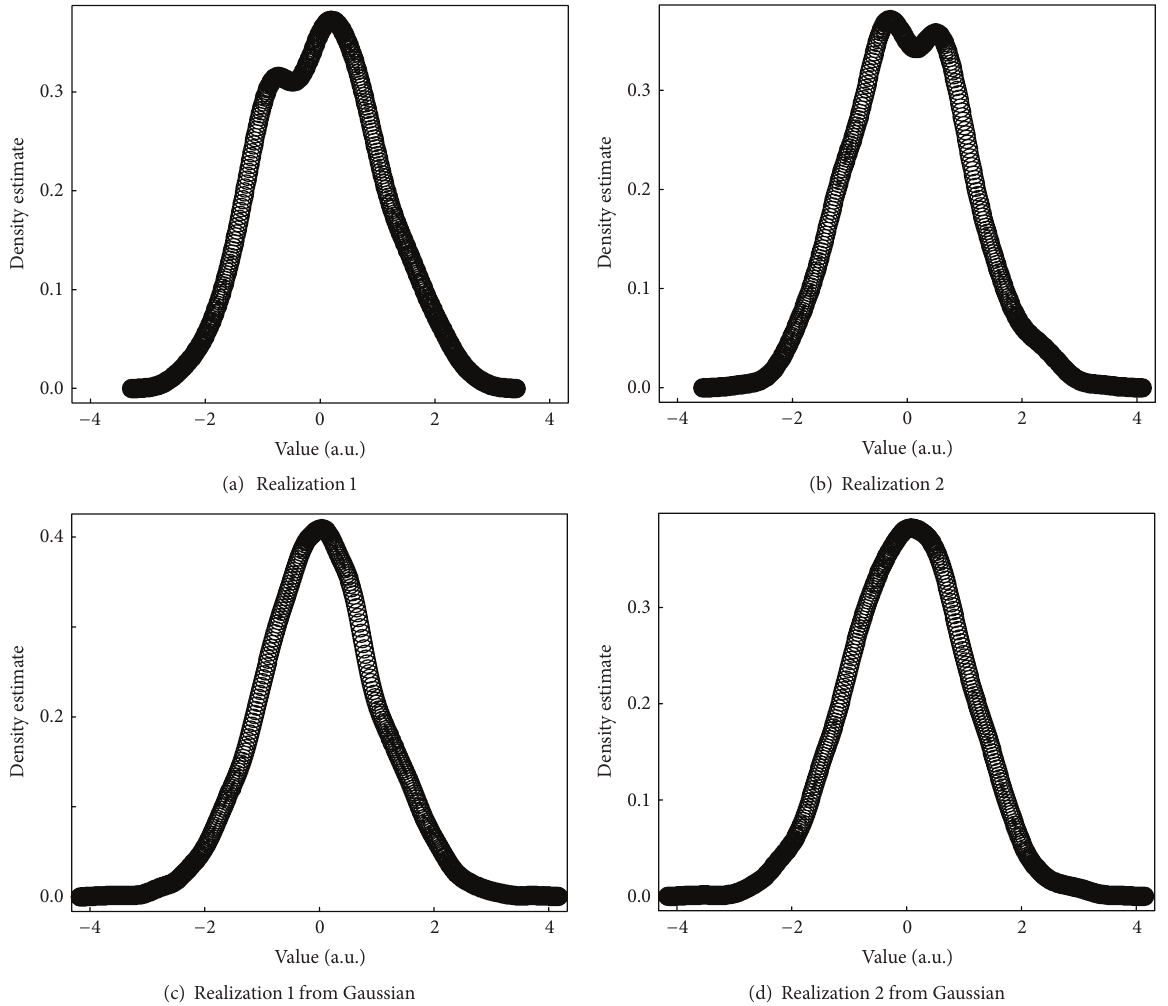
Figure 15: Realizations of 600 values in arbitrary units (a.u.). In (a) there are 600 MBs with cleanout between every batch of 3MBs, with the amount to holdup each period having a normal distribution. Subplot (b) is the same as (a), but with the amount to holdup each period having a uniform distribution. Subplots (c) and (d) are for 600 realizations from a normal distribution for